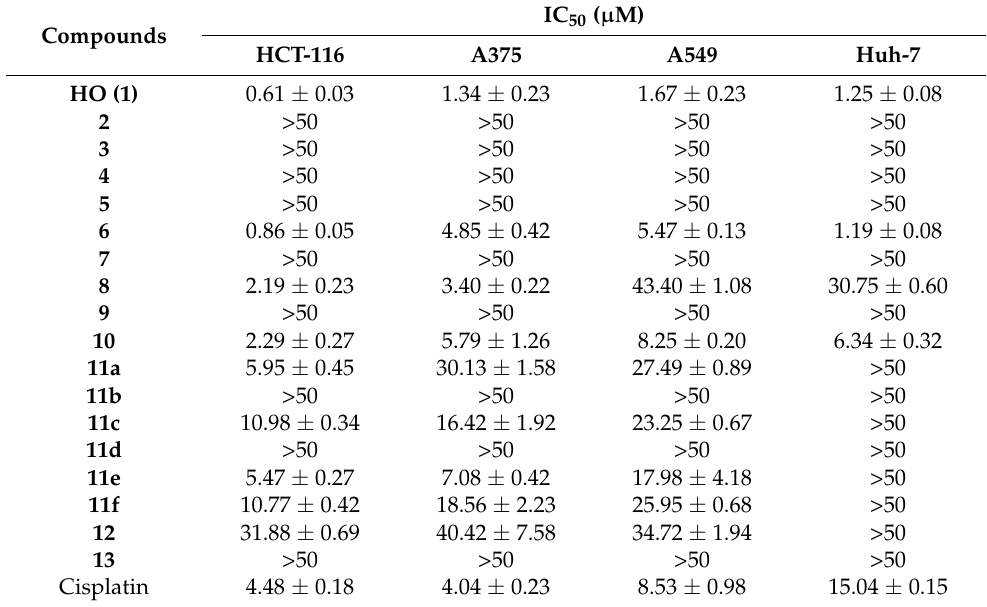
Table 1. The in-vitro cytotoxicity of the harringtonolide (HO) analogues.